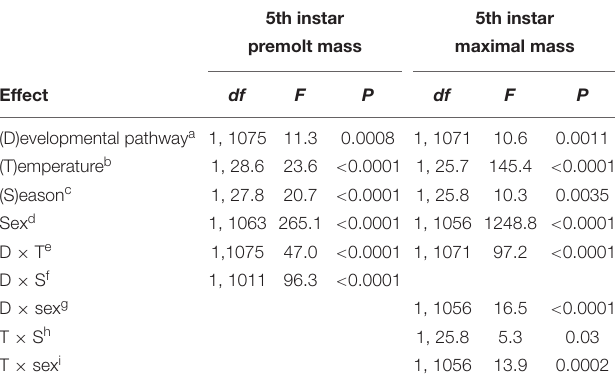
TABLE 7 | Fifth instar premolt mass (mass before the molt to the 5th instar) and 5th instar peak mass of Araschnia levana larvae as explained by developmental pathway, temperature, season, and sex; linear mixed models (SAS, Proc MIXED, type 3 sums of squares) with brood (progeny of one female) as a random